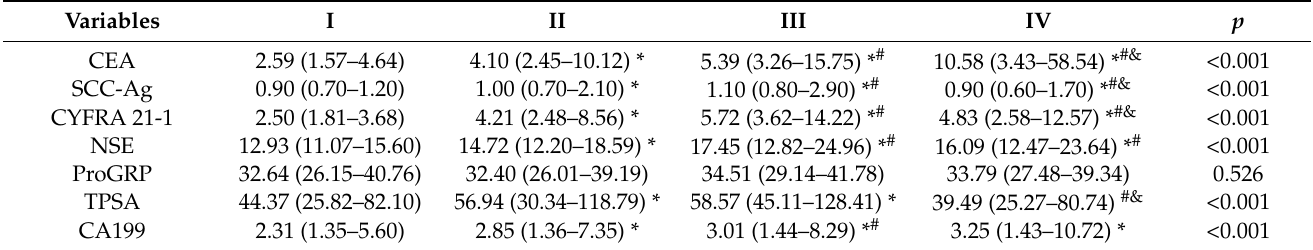
Table 4. The difference in clinical stages for the tumor markers in the patients with NSCLC (CEA, SCC-Ag, CYFRA21-1, NSE, ProGRP, TPSA and